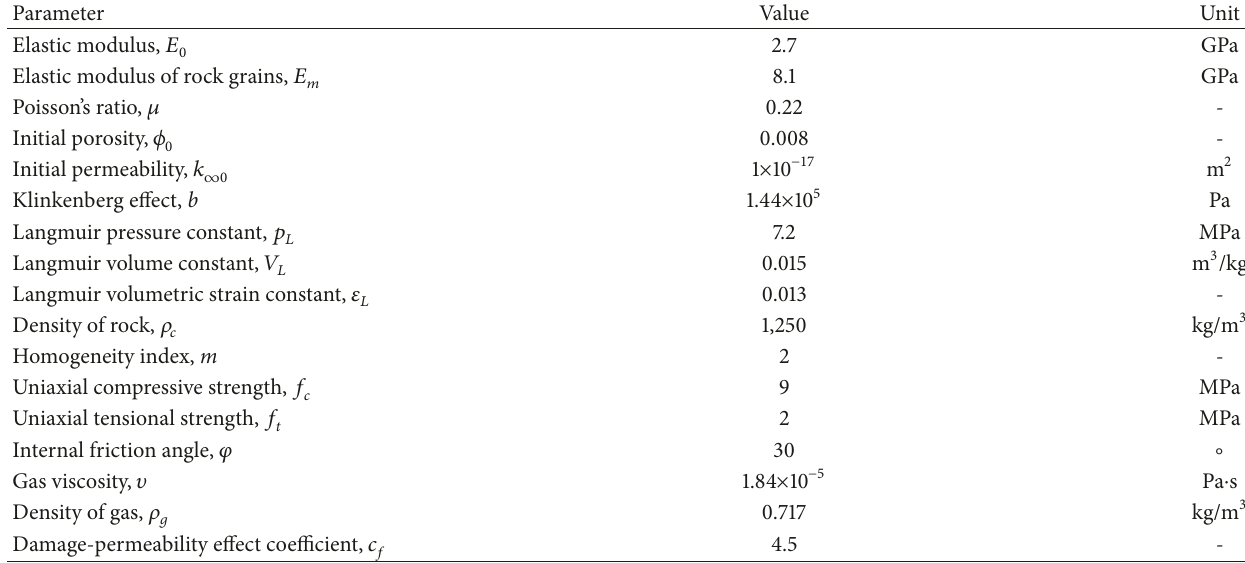
Table 1: Parameters in the